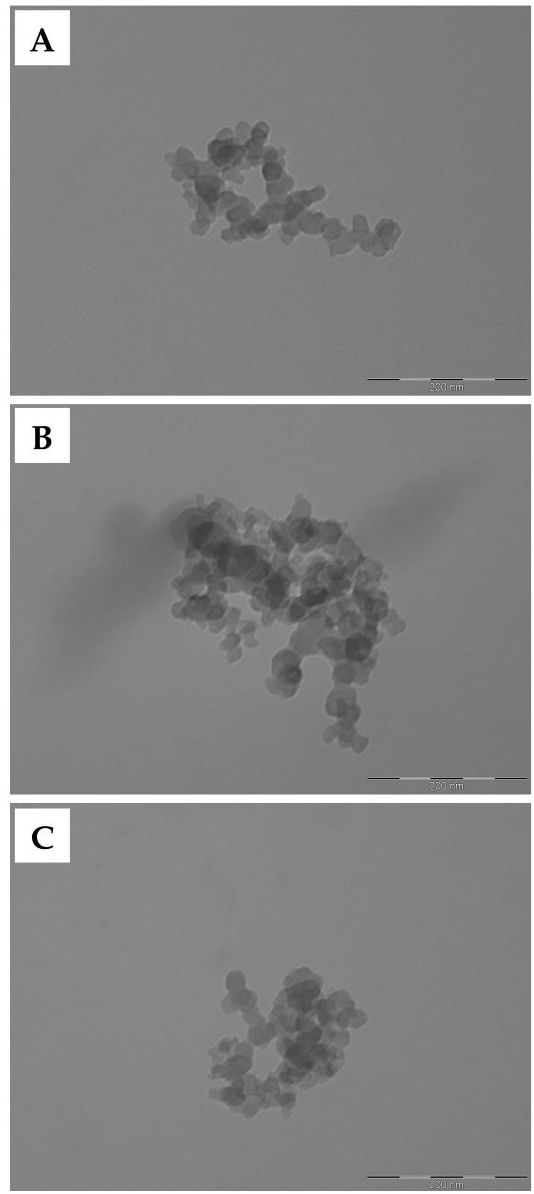
Figure 2. Morphological investigation by TEM of SFNs ( A ), SFNs-NDI-1 ( B ), and c RGD-SFNs-NDI-1 ( C ). Scale bar: 200 nm.